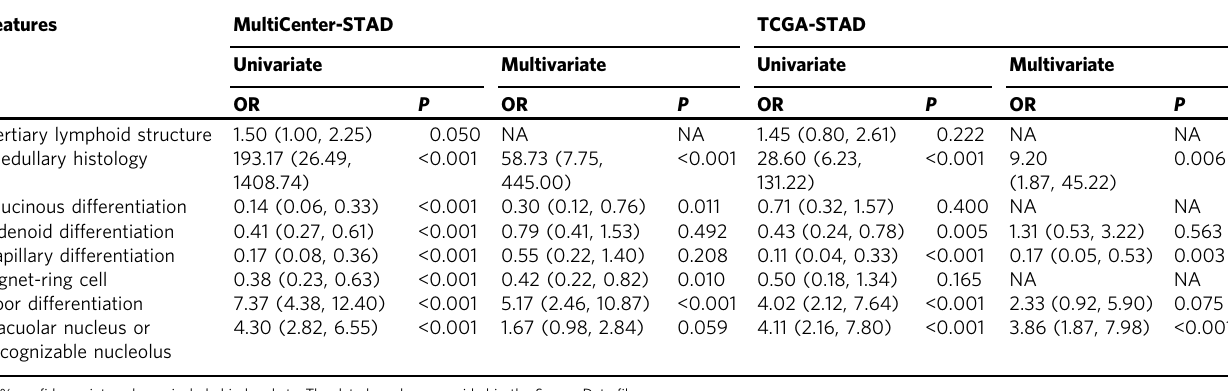
Table 3 Logistic regression models for the association between the morphological features and EBVNet ’ s prediction on external datasets.